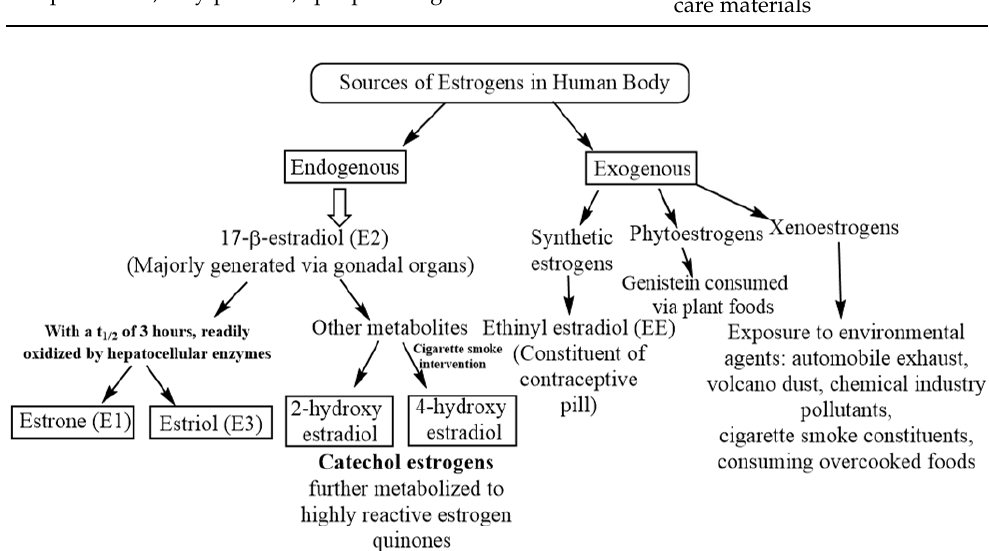
Figure 1. The different availability routes of estrogen in human body, distinguished into endogenous (within the body) and exogenous (outside the body). While exogenous sources present a greater diversity, endogenous estrogen is enabled through 17- β -estradiol (E2) and its metabolites. Of note, NSCLC accounts for about ~85% of all lung cancers [29] with an abysmal (13–18%) five-year survival rate [30,31]. Contrary to male gonads (testes), female